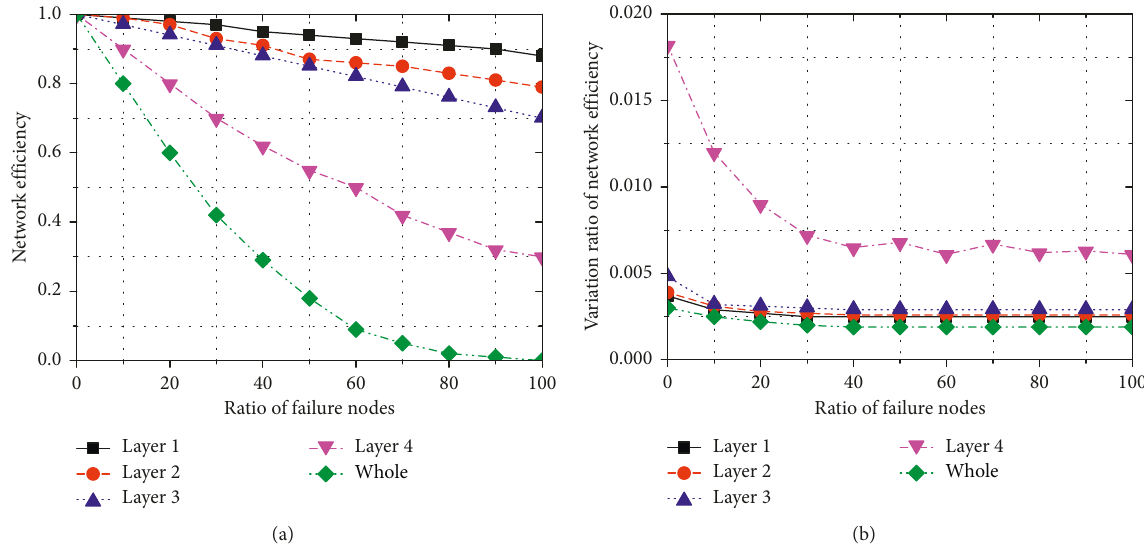
Figure 6: Network efficiency under targeted disruption. (a) Network efficiency. (b) Variation ratio of network